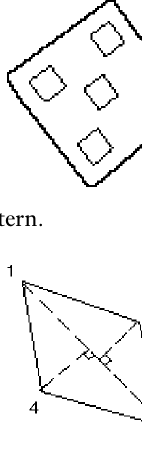
Figure 9 Case 2: extreme